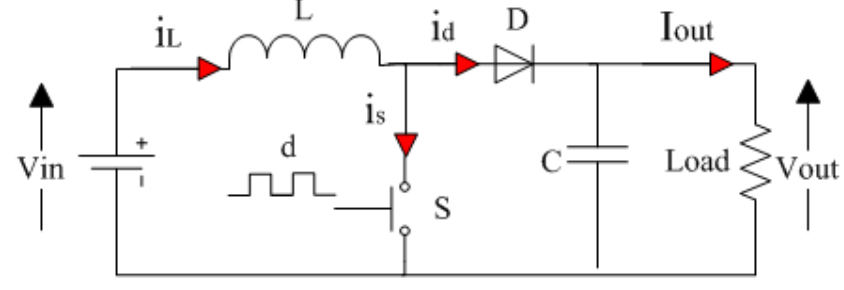
Figure 4. Ideal boost converter